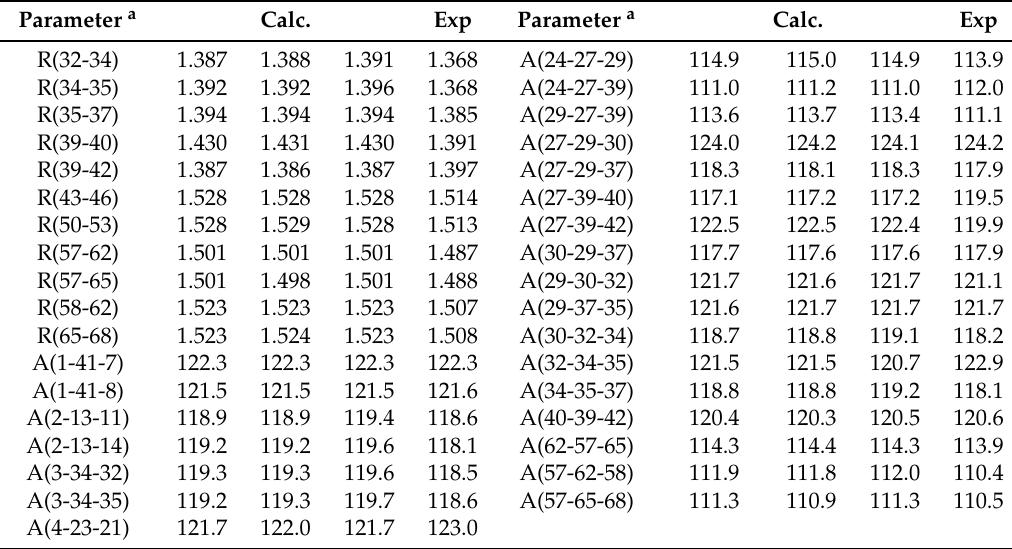
a For atom numbering, refer to Figure 3.